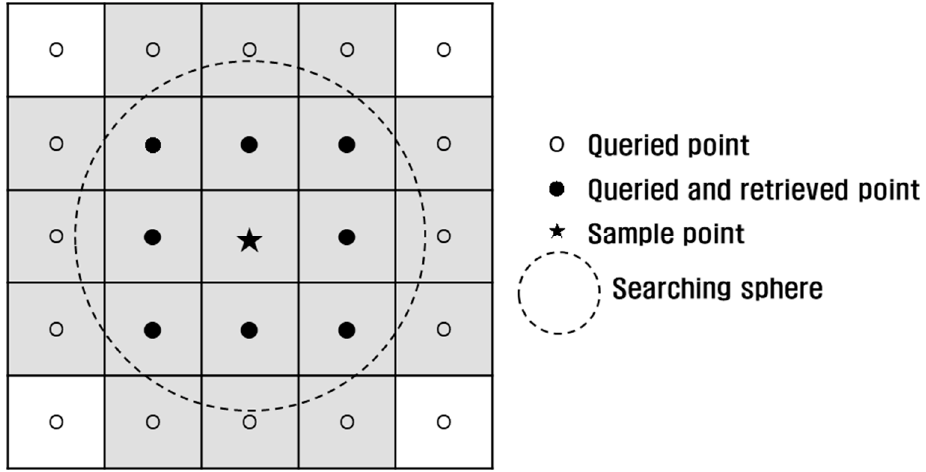
Figure 12. Proximity operation. Table 6. Specifications of proximity operation.